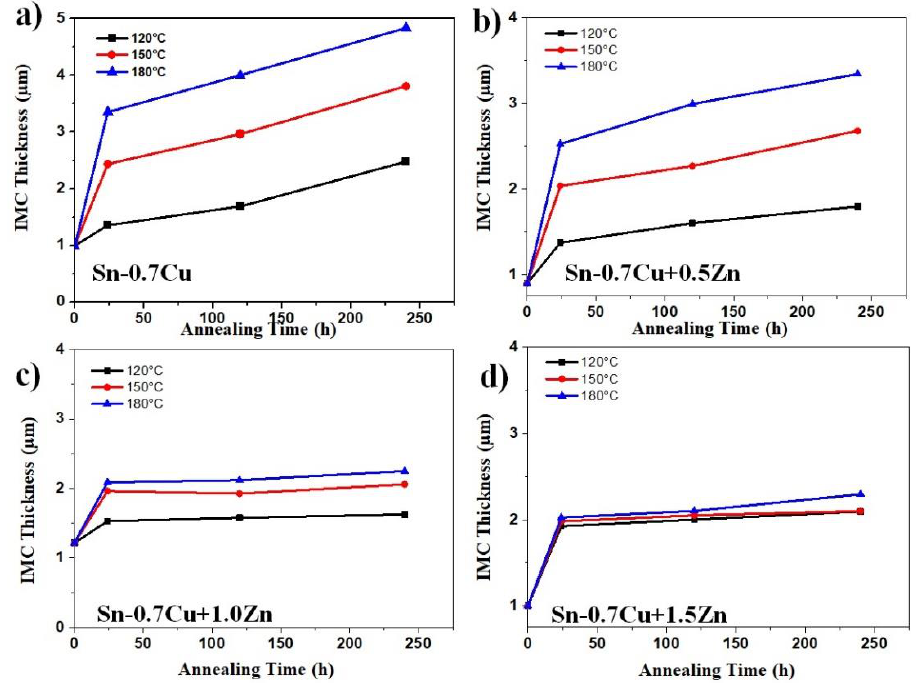
Figure 11. Effect of annealing on IMC thickness occurred at the interface of ( a ) Sn-0.7Cu, ( b ) Sn-0.7Cu-0.5Zn, ( c ) Sn-0.7Cu-1.0Zn, and ( d ) Sn-0.7Cu-1.5Zn.